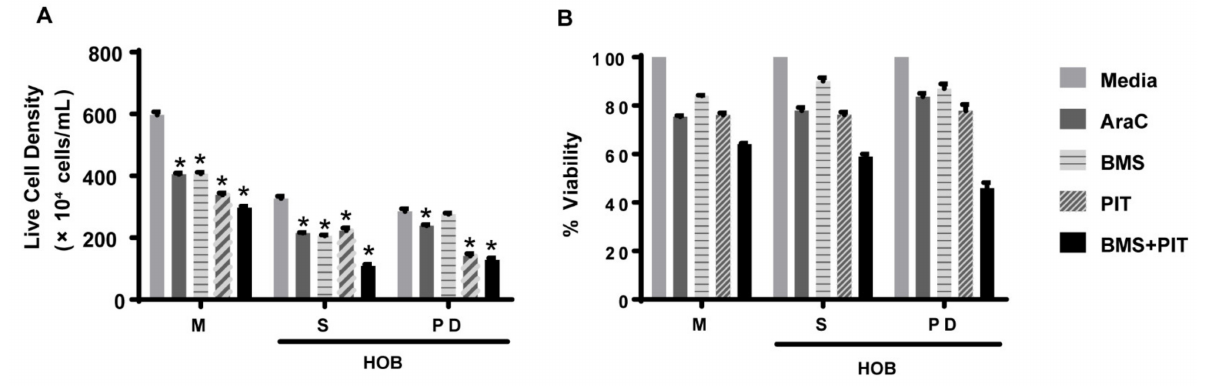
Figure 5. Pitavastatin decreases ALL cell viability in co-culture. REH cells were grown in a co-culture with HOB and were treated with Ara-C (0.1 µ M), BMS-303141 (BMS; 10 µ M), pitavastatin (PIT; 1 µ M) or a combination of BMS-141303 and pitavastatin (BMS + PIT). The cells in suspension (S) and the phase dim (PD) cells were isolated and compared to REH cells grown in media alone (M). The total cells and the live cell population ( A ) were used to calculate the % viability ( B ). The data is presented as mean ± SEM and is representative of a study performed in triplicate and conducted three independent times. * p < 0.05 when compared to vehicle/media